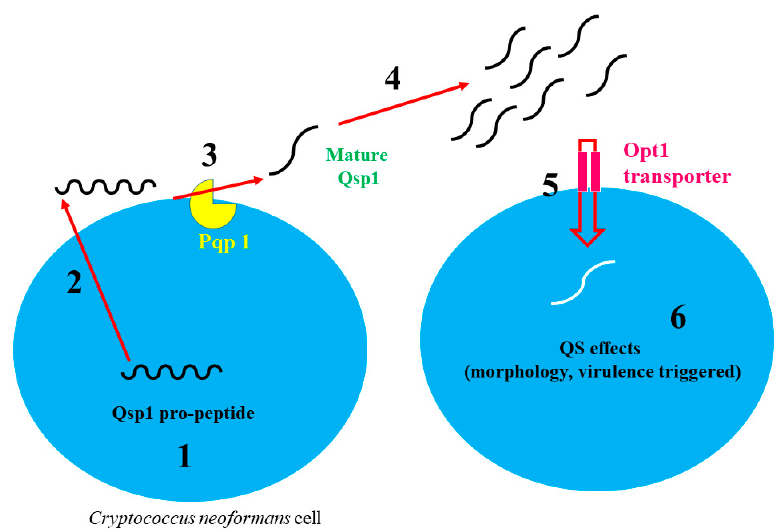
Figure 2. Quorum-sensing pathway in Cryptococcus neoformans (adapted from [26,31]). (1) Pro-peptide (QSP-1) is produced; (2) QSP-1 is excreted outside of the fungal cell; (3,4) it is broken down